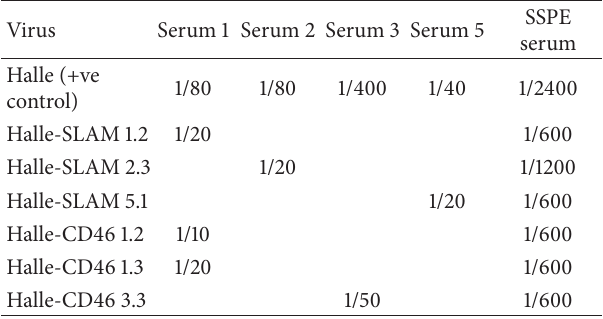
Table 4: Transient neutralization study of the six escape mutants selected for further